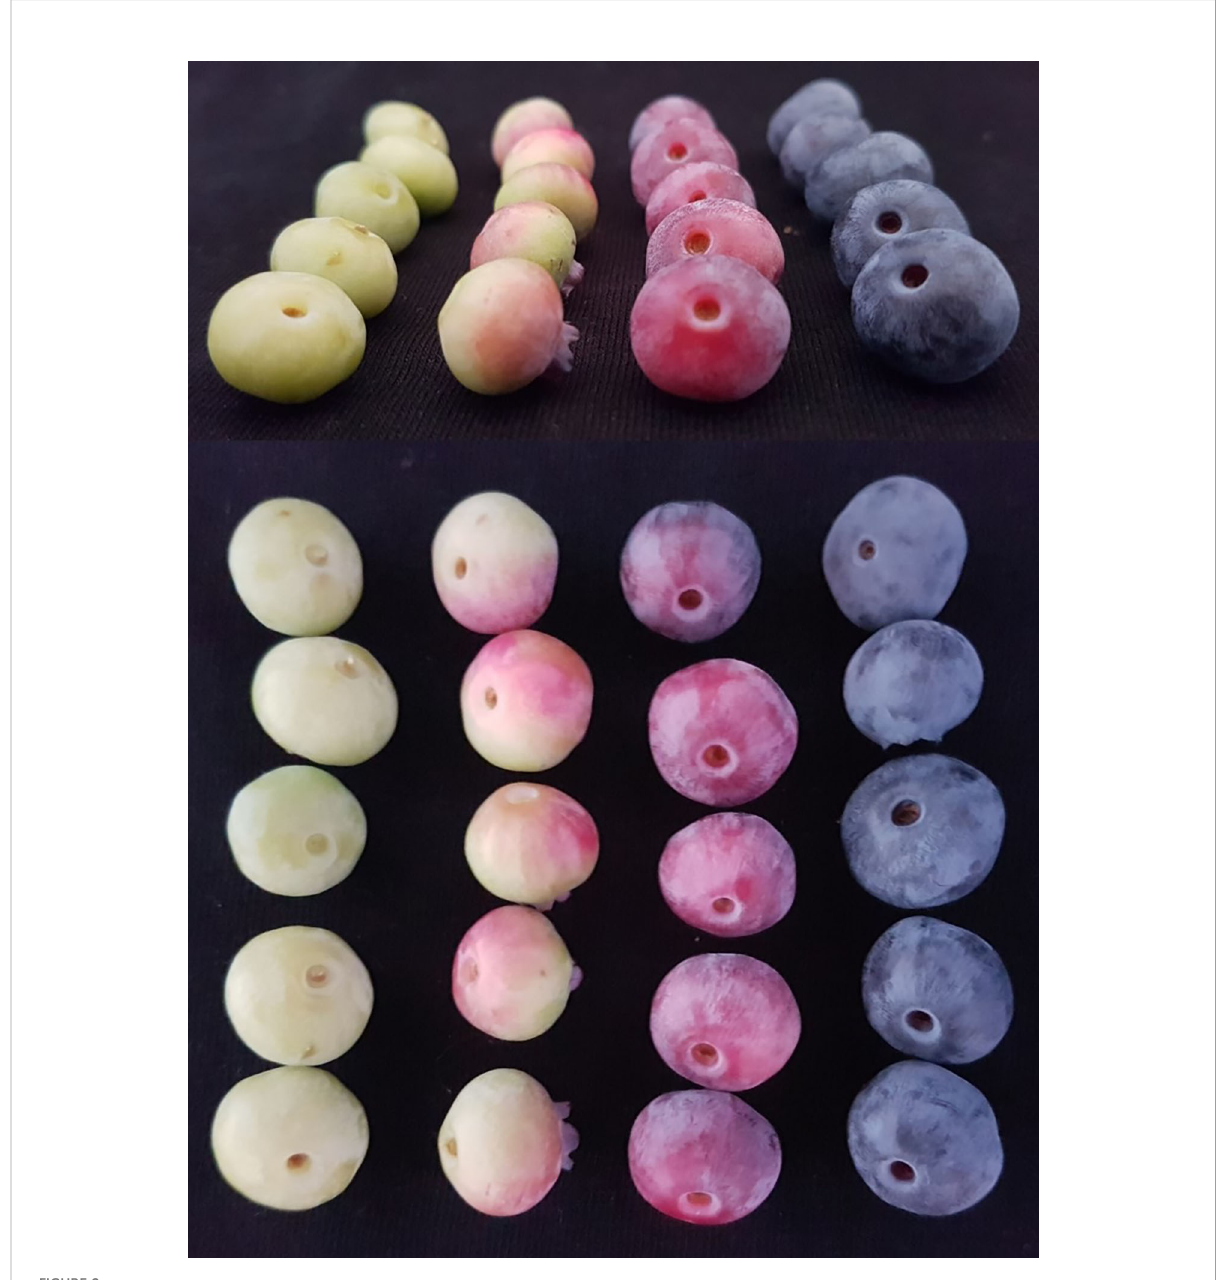
FIGURE 2 Different ripening stages of blueberry fruit (from left, stage 1: mature green, stage 2: less than 50% pigmented, stage 3: 50% to completely pigmented except the stem end, stage 4: fully